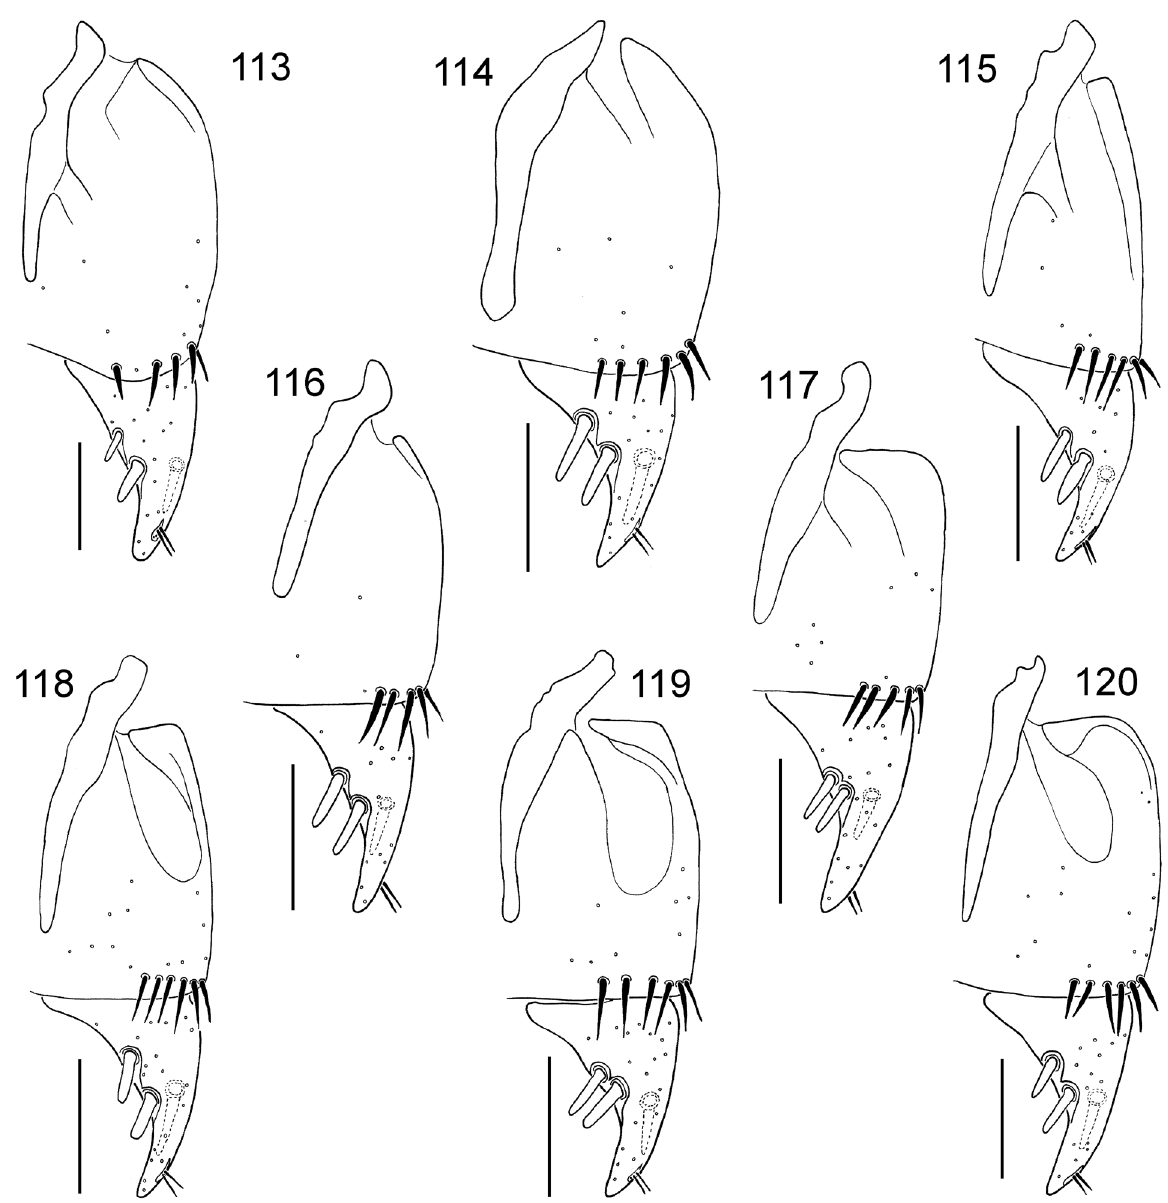
Figures 113–120. Female right gonocoxae, ventral view, for Cyphocoleus spp. illustrating apical fringe setae of basal gonocoxite 1, and two lateral ensiform setae, one dorsal ensiform seta, and two apical nematiform setae on apical gonocoxite 2; 113 , C. fasciatus , Mt. Panié; 114 , C. cychroides , Pic d’Amoa; 115 , C. latipennis Mt. Panié; 116 , C. cordatus , Forêt Nord; 117 , C. globulicollis , Col des Roussettes; 118 , C. flavipes , Nouméa; 119 , C. bourailensis , Bourail; 120 , C. subulatus , Forêt de Thi. Scale bar, 0.10